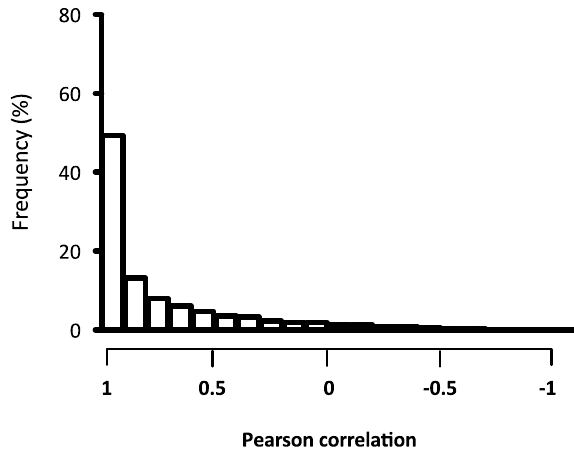
Figure 2. Correlation between levels of gene expression measured by Probe_1 and Probe_2. For each gene, the Pearson correlation coefficient was calculated within and between arrays.